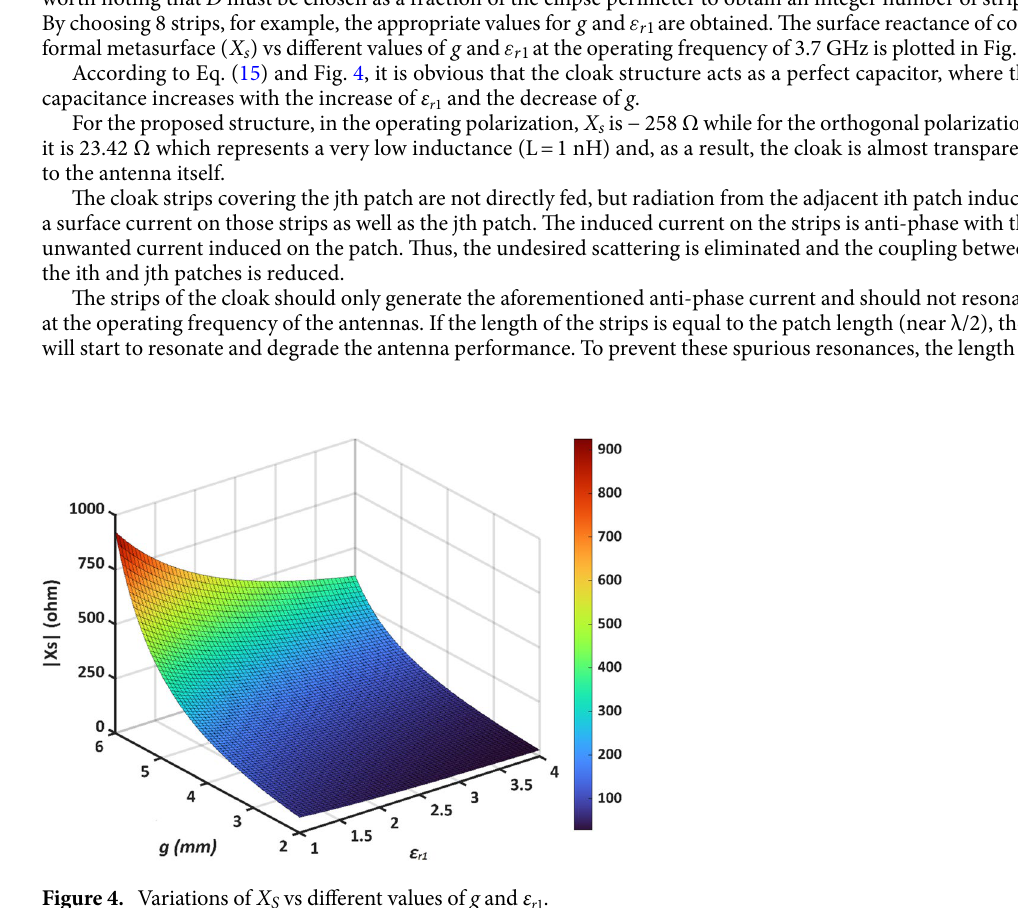
Figure 4. Variations of X S vs different values of g and ε r 1